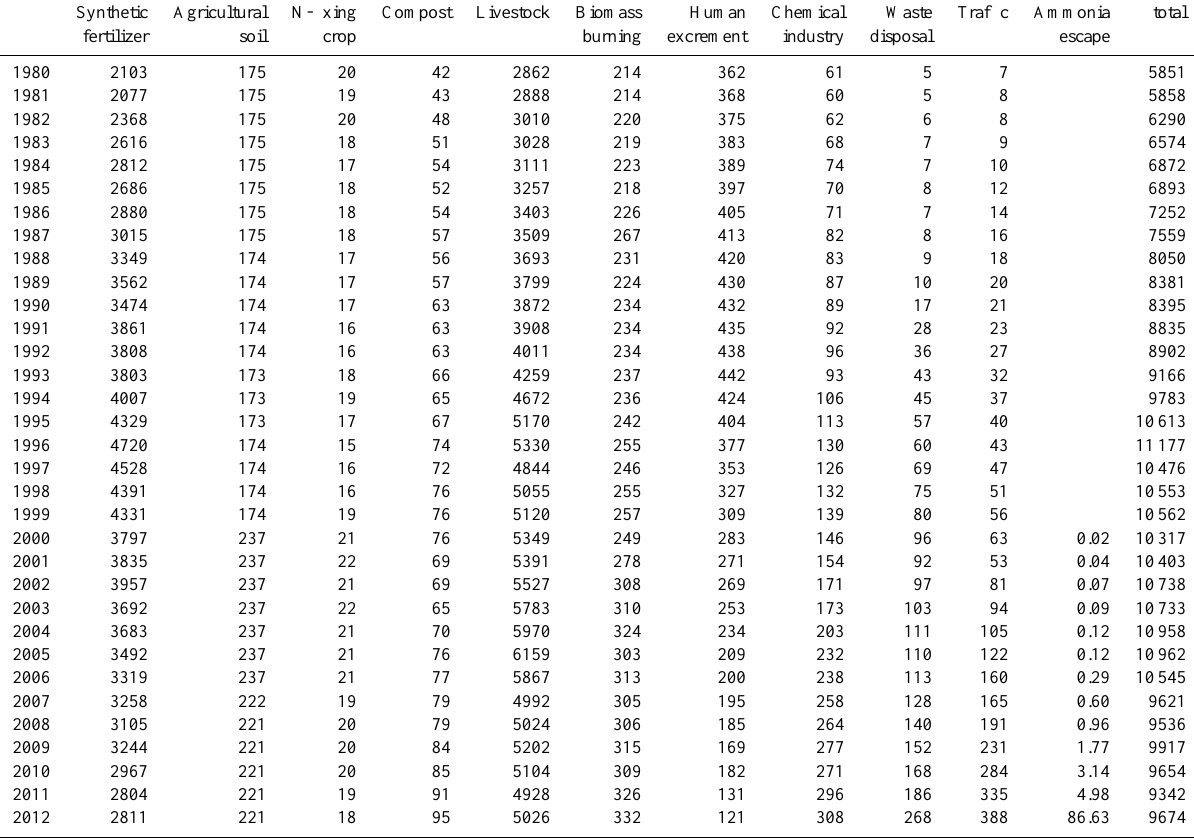
Table 2. Contributions to NH 3 emissions (Gg) from various sources from 1980 to 2012.